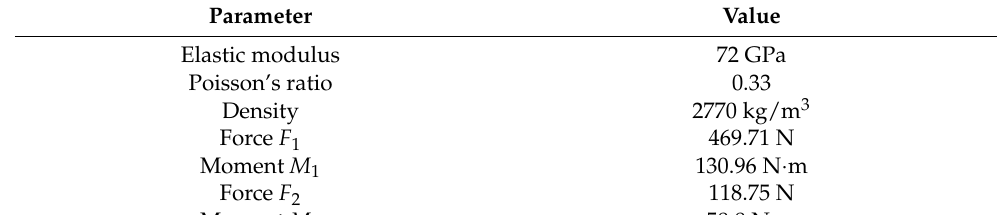
Table 1. Material properties and loads.